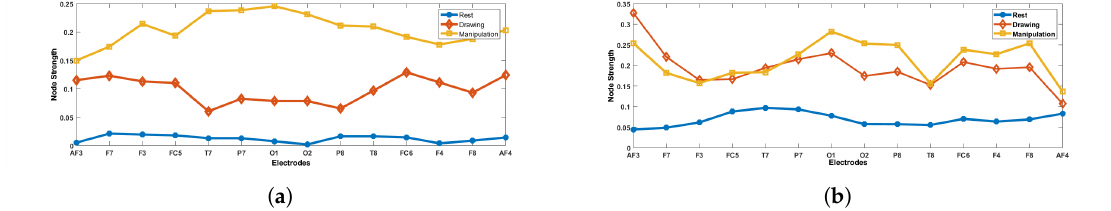
Figure 13. Comparison of node strength across electrodes during rest, drawing and manipulation states. ( a ) User 3 (Novice). ( b ) User 8 (Expert).